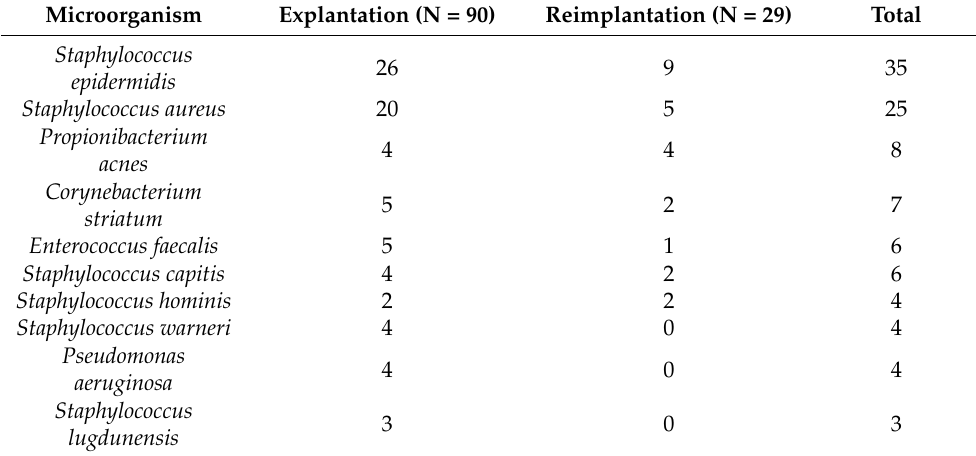
Table 2. Pathogens isolated at explantation and